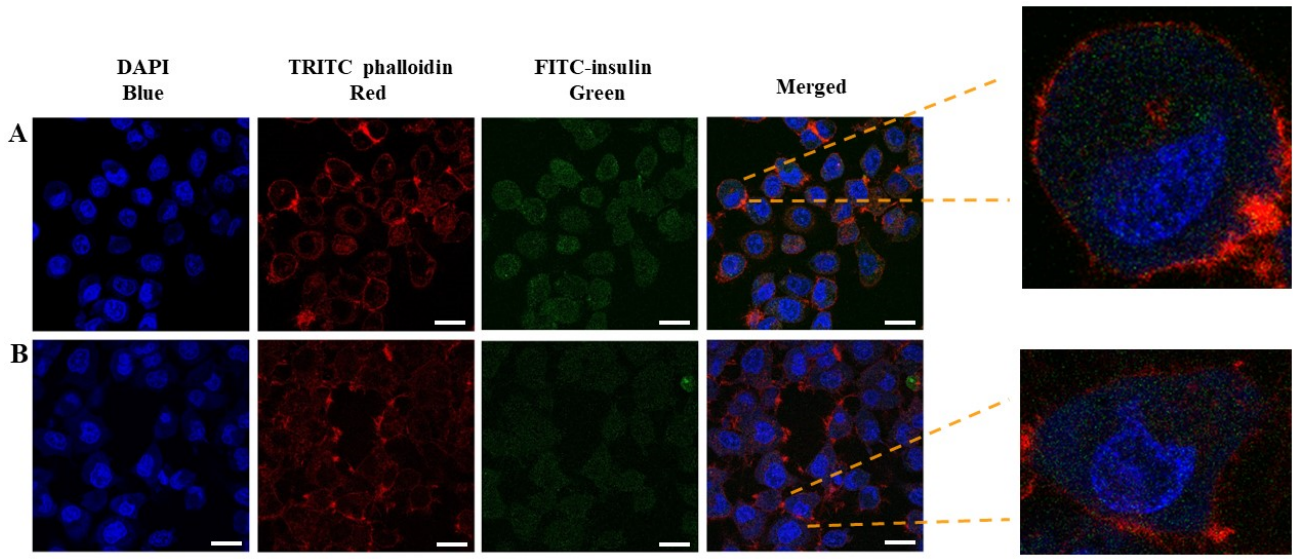
Figure 7. Confocal images of TR146 cell layers after treatment for 2 h. ( A ) Treatment with FITC-IPC- DNVs, ( B ) Treatment with FITC-IPC-DNV-TSG. Scale bar is 25 µ m. Blue: Nucleus; Red: Cytoskeleton; Green: FITC-insulin.